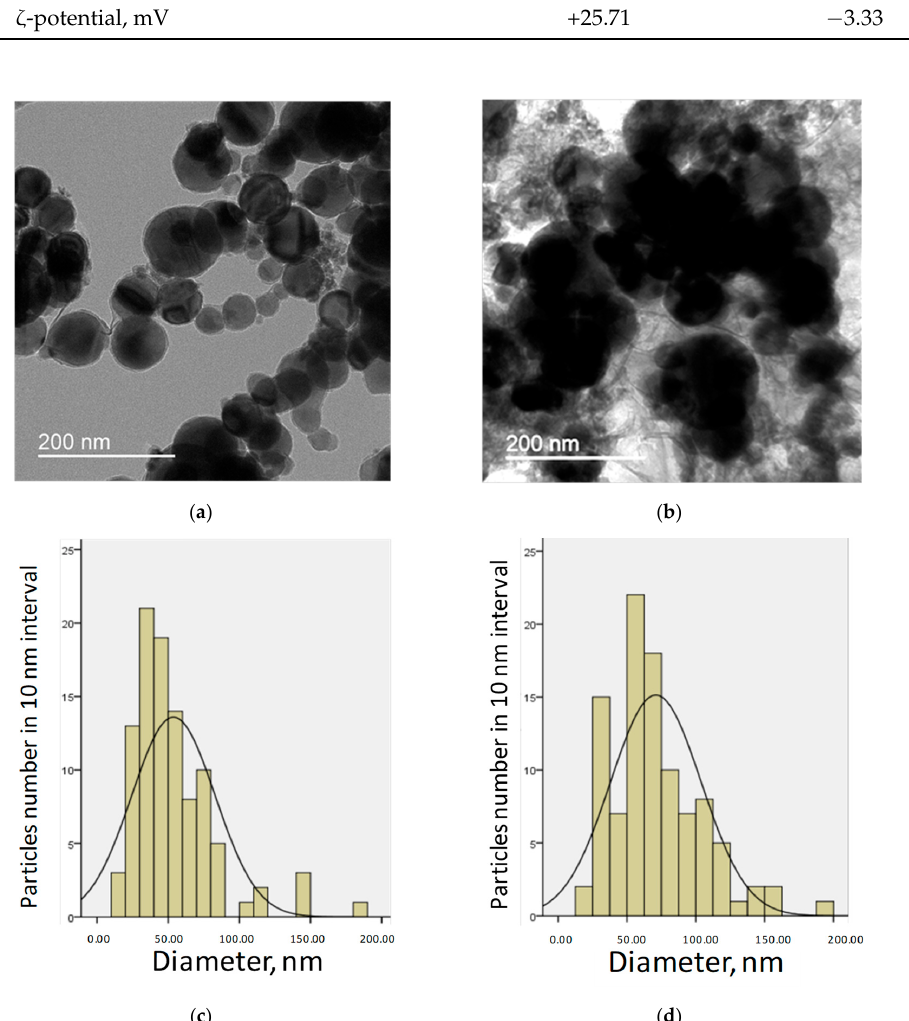
Figure 2. Characterization of metallic Ni NPs of two sizes by TEM. ( a , c )—Ni NP1; ( b , d )—Ni NP2. Representative micrographs ( a , b ) and histograms of particle diameter distribution ( c , d ).